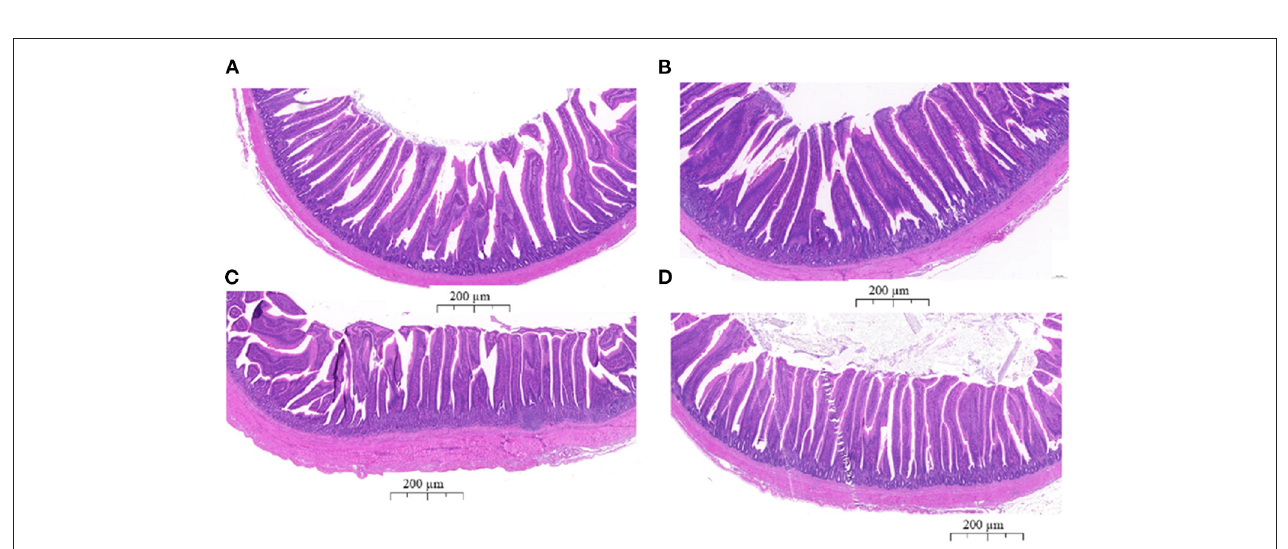
FIGURE 2 | The histological analyses of the jejunum and ileum tissues from the control group (A,C) and EP supplemented (B,D) broiler chickens stained with hematoxylin and eosin. (A) Jejunum tissue from the control group; (B) jejunum tissue from the EP group; (C) Ileum tissue from the control group; (D) Ileum tissue from the EP group. The scale bar represents 200 µ